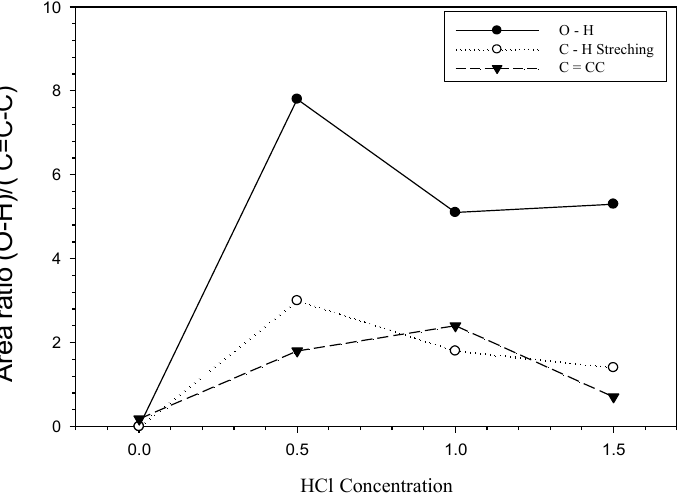
Figure 4. Deconvoluted peak area ratios of activated carbon concentration at adsorber membrane.